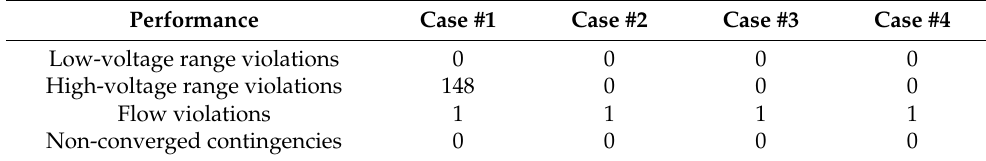
Table 9. Results of grid-security